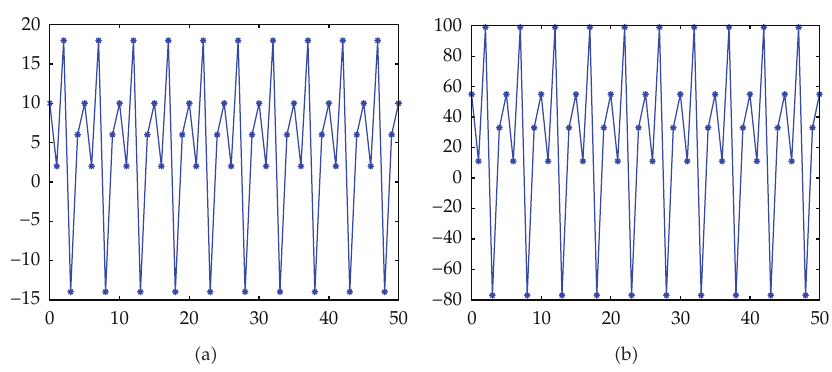
Figure 2: Equation (cid:3) 1.4 (cid:4) r (cid:8) − 7 / 15. (cid:3) a (cid:4) : Initial values y 0 (cid:8) 10, y 1 (cid:8) 2, y 2 (cid:8) 18 (cid:3) t (cid:8) 2 (cid:4) ; (cid:3) b (cid:4) : Initial values